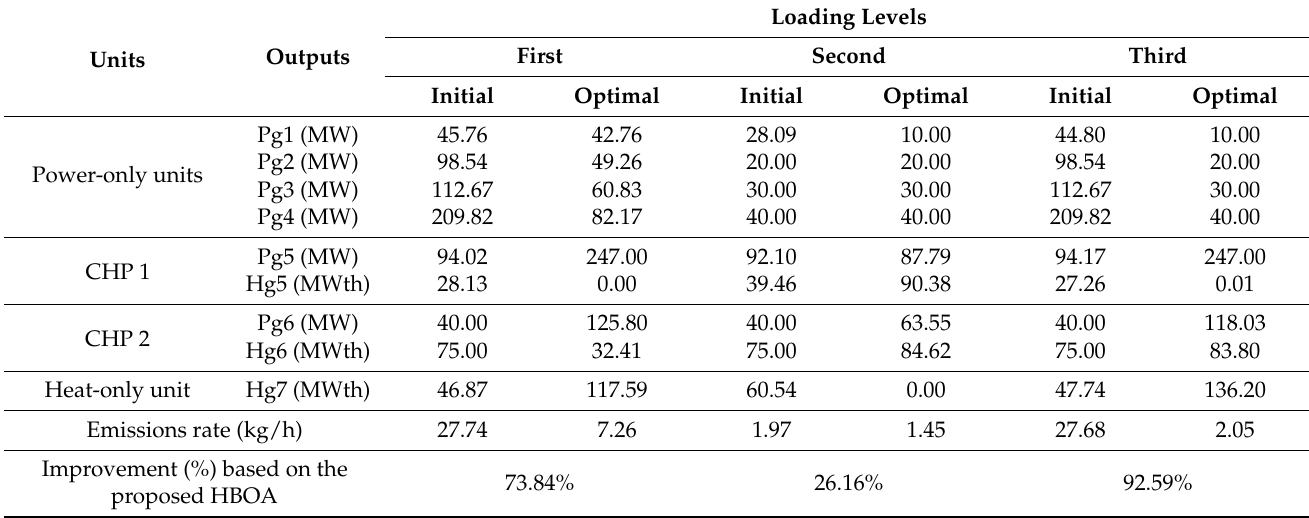
Table 9. Results of the proposed HBOA of Case 4 for the three loading